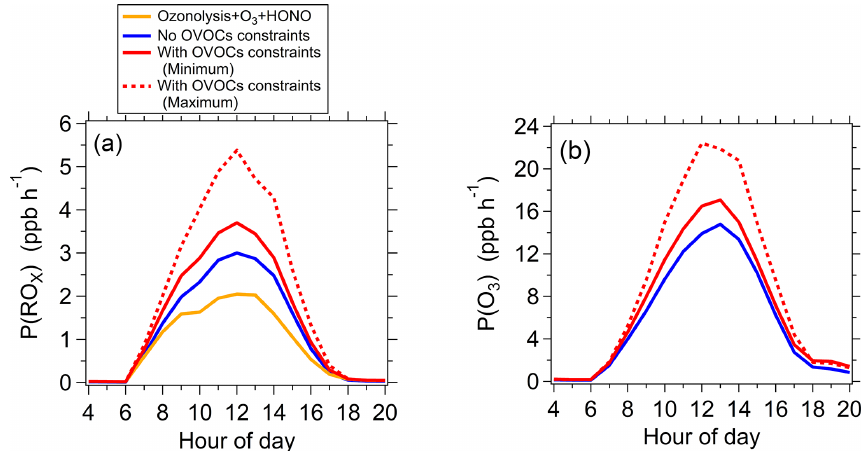
Figure 3. Model simulated P (RO x ) (a) and P (O 3 ) (b) without and with all observed photodegradable OVOCs constrained. (a) Model simulated P (RO x ) without (blue line) and with (red lines) all observed photodegradable OVOCs constrained. The sum contribution of O 3 photolysis, HONO photolysis, and ozonolysis is also displayed (yellow line). (b) Model simulated P (O 3 ) without (blue line) and with (red lines) observed photodegradable OVOCs constrained. The red solid and red dashed lines represent the scenarios with minimum and maximum OVOC contributions to P (RO x ),